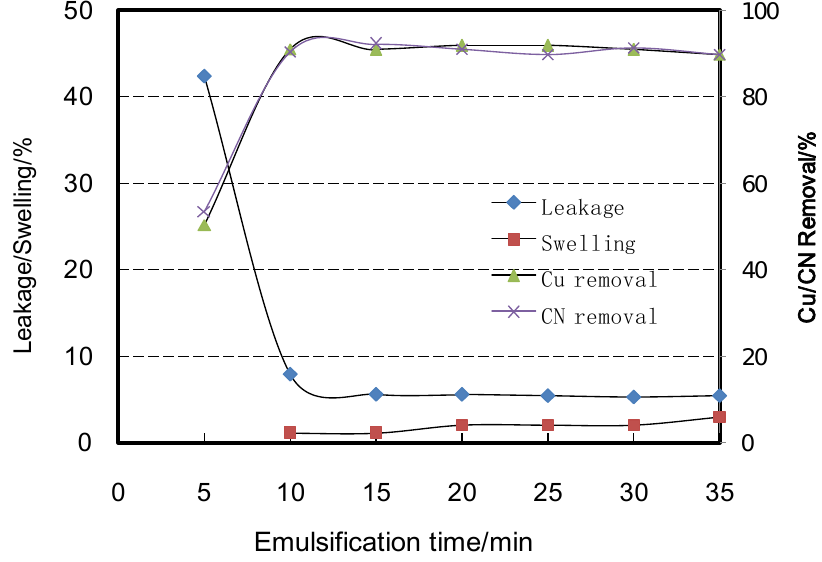
Figure 2. Effect of emulsification time on ELM stability and copper and cyanide removal. (For ELMs formation, membrane phase: 6% v / v LIX 7950, 2% v / v 1-dodecanol, 5% v / v Span 80, 1% v / v liquid paraffin, balanced with kerosene; Internal solution: 0.05 mol/L KOH; Volume ratio of membrane to internal phases: 1:1; Mixing speed: 4500 RPM. The external aqueous phase: dilute copper cyanide solution, [Cu]